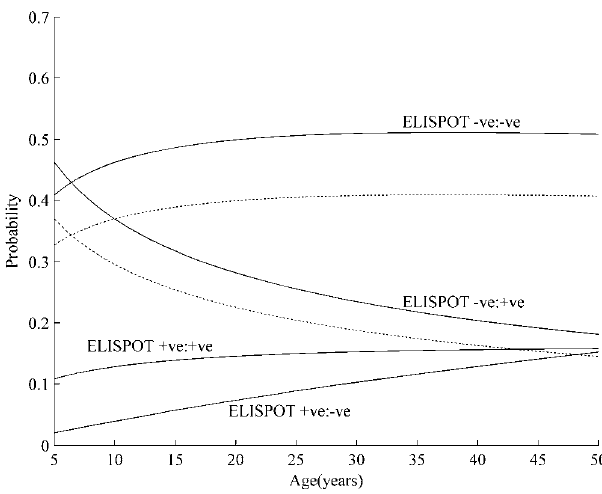
Figure 2. Estimates, according to age, of the probability of TB case contacts that undergo tuberculin conversion having each of the 4 possible combinations of ELISPOT results over the 2 sampling points (recruitment and after 3 months). The estimates are derived from the study data using multi-nomial logistic regression and the analysis is restricted to those aged 5–50 years (see methods). The dotted lines represent the predicted probabilities if the sensitivity (ELISPOT 2 ve: + ve group) and specificity (ELISPOT 2 ve: 2 ve group) of the ELISPOT are both 80% (see methods).